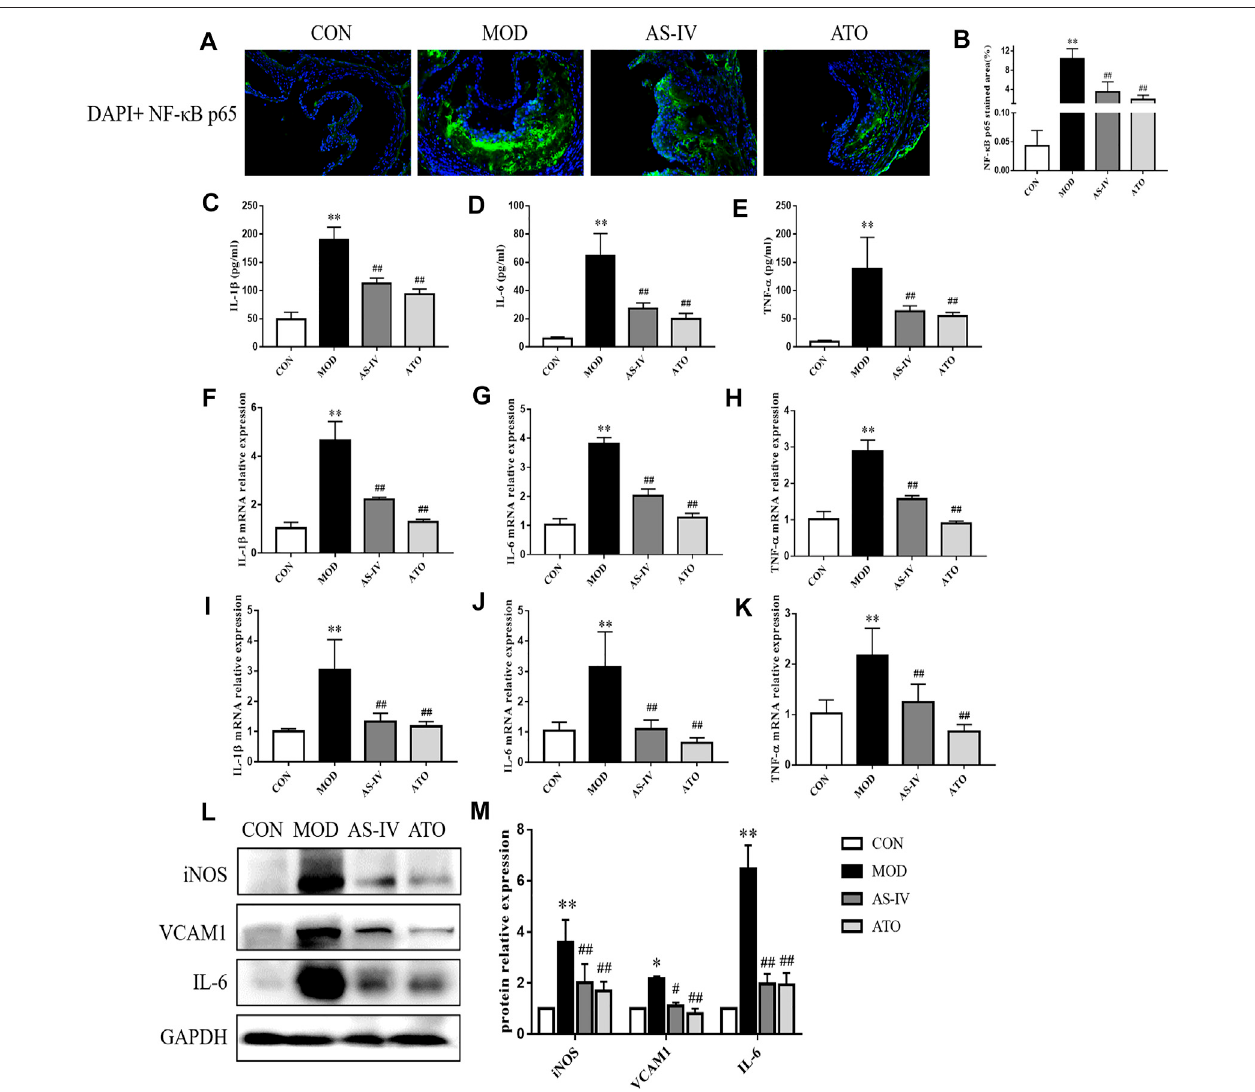
FIGURE4 | In fl ammatory cytokines in the LDLR − / − mice. (A,B) Representative photomicrographsof aortic root sections stained with NF- κ BP65 in atherosclerotic plaquefollowedbythequanti fi cation,magni fi cation×200, n =6. (C – E) ProductionofIL-1 β ,IL-6andTNF- α inserumweremeasuredbyELISAkit, n =8.Aorta (F – H) and livertissue (I – K) geneexpressionofIL-1 β ,IL-6andTNF- α weredetectedbyRT-qPCRmethod, n =8. (L) Proteinwasextractedfrommiceaorta.ThenthelevelsofiNOS, VCAM-1 and IL-6 were determined by western blotting assay, n = 3. (M) The quantitative results were depicted. CON means control group, MOD means model group, AS-IV means Astragaloside IV group, ATO means Atorvastatin group. Data are expressed as mean ± SD. ** p < 0.01 versus CON group; ## p < 0.01 versus MOD group.